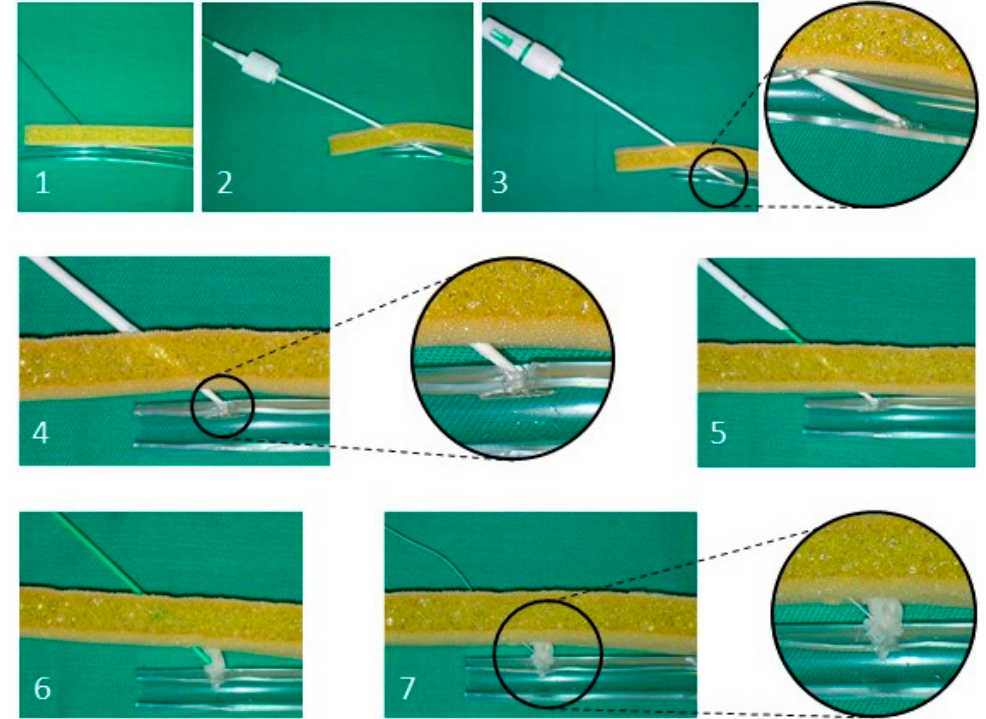
Figure 4. Schematic representations of the main steps in the application of the Angio-Seal VIP system. The yellow cancellous material represents the skin and subcutaneous tissue. The transparent plastic tube represents the artery. ( 1 ) guidewire advanced into the artery after withdrawal of the former introducer sheath. ( 2 ) Angio-Seal insertion sheath advanced over the guidewire (at this moment, blood flow through the locator confirms the proper position of the sheath). ( 3 ) insertion of Angio-Seal device into the sheath and deployment of the anchor. ( 4 ) Angio-Seal device is pulled back until the anchor is properly located. ( 5 ) all the assembly is pulled back until the colour tube appeared. ( 6 ) advance the compaction tube until feeling resistance. ( 7 ) compaction tube has been removed and collagen sponge has been deployed in place, and it is attached to the suture that still has to be cut.